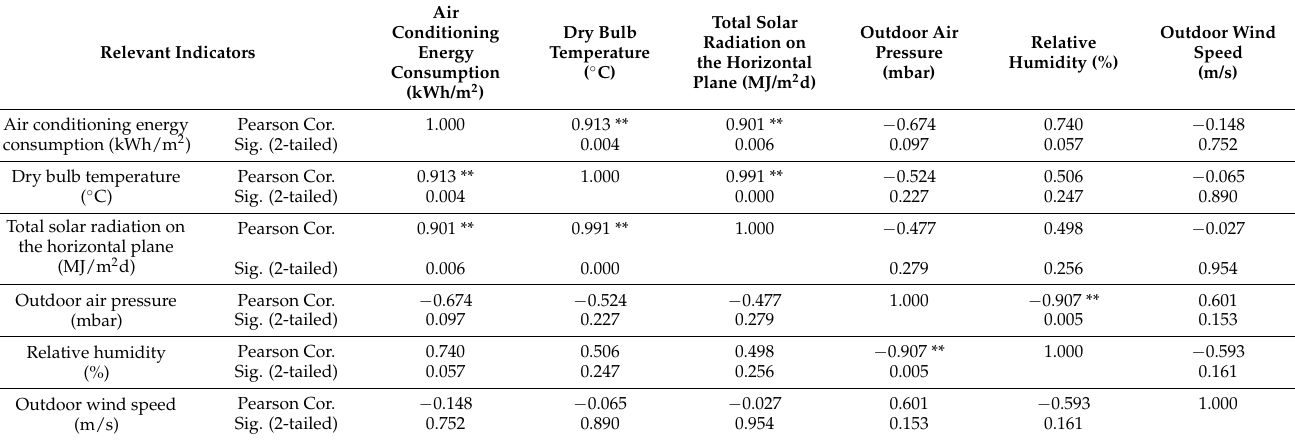
Table 8. SPSS-related analysis of building energy consumption in existing service districts.